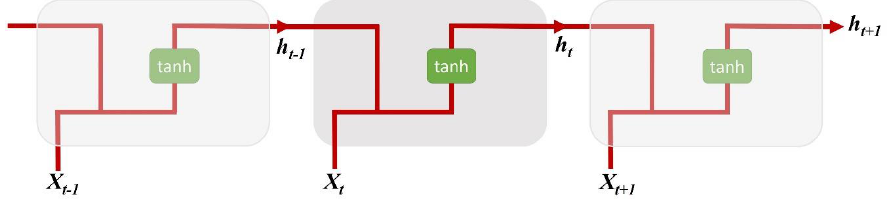
Figure 4. The structure of the recurrent neural network.